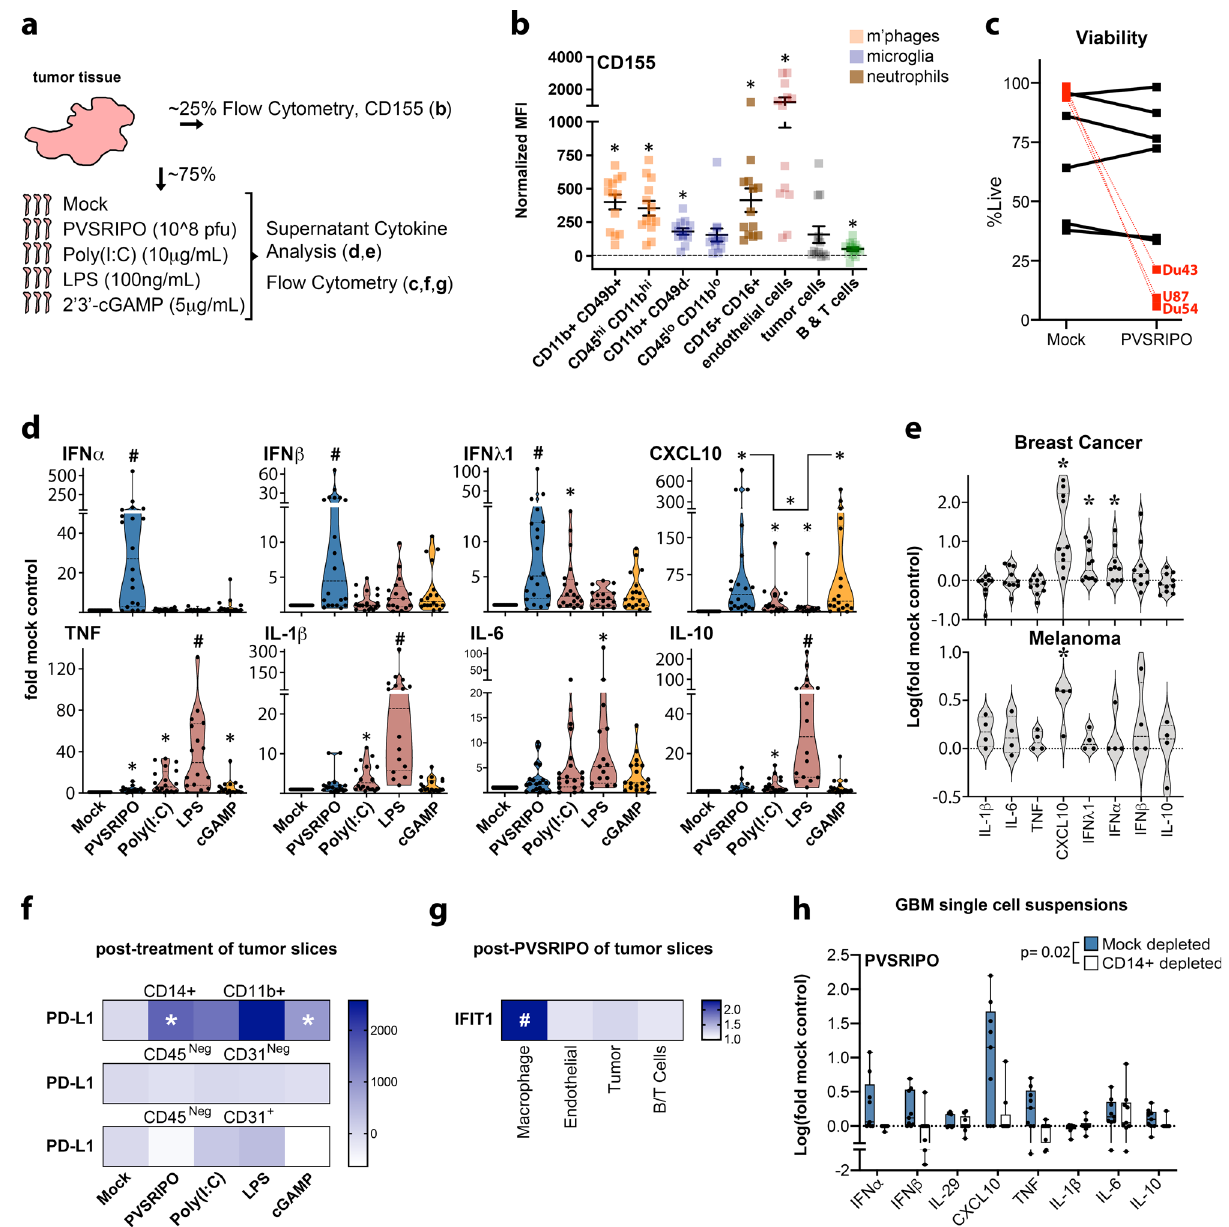
Fig. 1 PVSRIPO treatment of ex vivo tumor tissue induces type-I/III IFN in TAMs. a Fresh glioblastoma (GBM) tissue was analyzed for distribution of surface CD155 by cell type and responsiveness to innate stimuli. b GBM single-cell suspensions were analyzed for CD155 expression via fl ow cytometry ( n = 13 tumors, see Supplementary Fig. 1 for gating); asterisks denote Bonferroni corrected one-sample t test ( p < 0.0064, two-tailed, from left to right: p = 0.0001, 0.0001, 0.0001, 0.007, 0.0005, 0.0008, 0.03, 0.005). Normalized MFI (median fl orescence intensity) was calculated by subtracting isotype control from stained MFI values for each cell type; mean ± SEM is shown. c , d Tumor slices were treated with PVSRIPO, Poly(I:C), lipopolysaccharide (LPS), or 2 ′ 3 ′ -cGAMP as shown; pfu = plaque forming units. Post-treatment cell viability was measured after PVSRIPO treatment [7-AAD staining; n = 6 GBM, n = 3 glioma cell lines (DU54, DU43, and U87; mean of 3 experiments per cell line is shown)] ( c ) and fold-mock control cytokine release in supernatant was examined after all treatments ( d ; n = 20 for mock, PVSRIPO, and Poly(I:C); n = 15 for LPS; n = 18 for cGAMP). Only induced cytokines are shown; see Supplementary Fig. 2 for patient-speci fi c induction; Tukey ’ s post-hoc p < 0.05 (two-tailed) vs mock (*), unless otherwise indicated by bracket, or vs all other groups (#). e Ex vivo slice assay using breast cancer tissue ( n = 10) and melanoma tissue ( n = 4) testing only PVSRIPO as in ( d ); (*) one-sample t test p < 0.05 (two-tailed; d: CXCL10 p = 0.003, IFN- λ 1 p = 0.02, IFN- α p = 0.03; e: CXCL10 p = 0.03). d , e Violin plots present quartiles and median. f , g Dissociated, post-treatment tumor slices were analyzed by fl ow cytometry for PD-L1 expression [ f , n = 6 GBM, normalized MFI — mock MFI is shown, (*) one-sample t test p < 0.05 (two-tailed): CD14 + CD11b + PVSRIPO p = 0.02, cGAMP p = 0.02] and intracellular IFIT1 expression for indicated cell types [ g , n = 4 GBM and 2 breast cancer, fold-mock control MFI for each cell type is shown, (#) Tukey ’ s post-hoc test vs all other groups: macrophage vs: endothelial p = 0.0005, tumor p = 0.001, B/T cells p = 0.0004]; see Supplementary Fig. 3 for gating and extended data. h Fresh ( n = 3) and previously frozen ( n = 6) GBM cell suspensions were subjected to mock or CD14 + depletion. Cell count-normalized mock- and CD14 + -depleted suspensions were treated with PVSRIPO (48 h) and supernatant cytokines were measured; box shows median with quartiles and whiskers indicate range; p -value is from paired t -test (two-tailed) comparing the sum of log(fold-mock control) cytokine values; see Supplementary Fig. S4 for extended data.